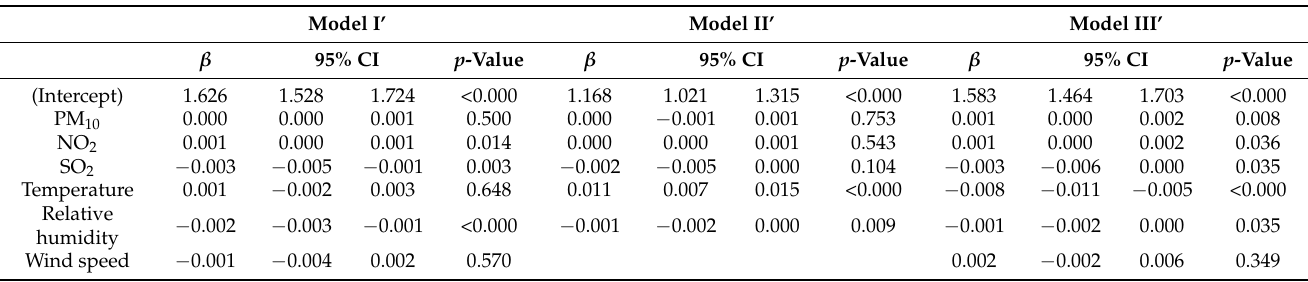
Table 2. Estimated parameters for Models I’, II’, and III’. The generalized linear models were elaborated on SPSS software considering gamma distribution and a loglink equation.